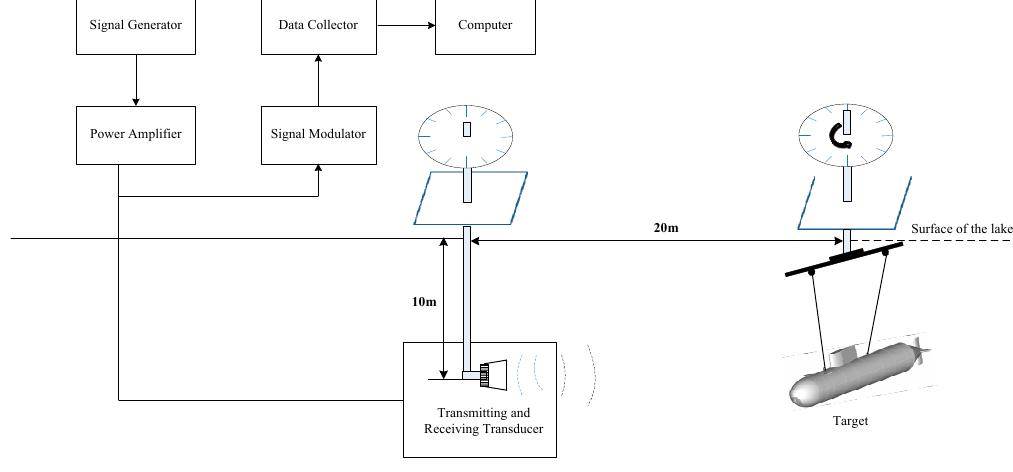
Figure 7. Deployment method in the test [28].